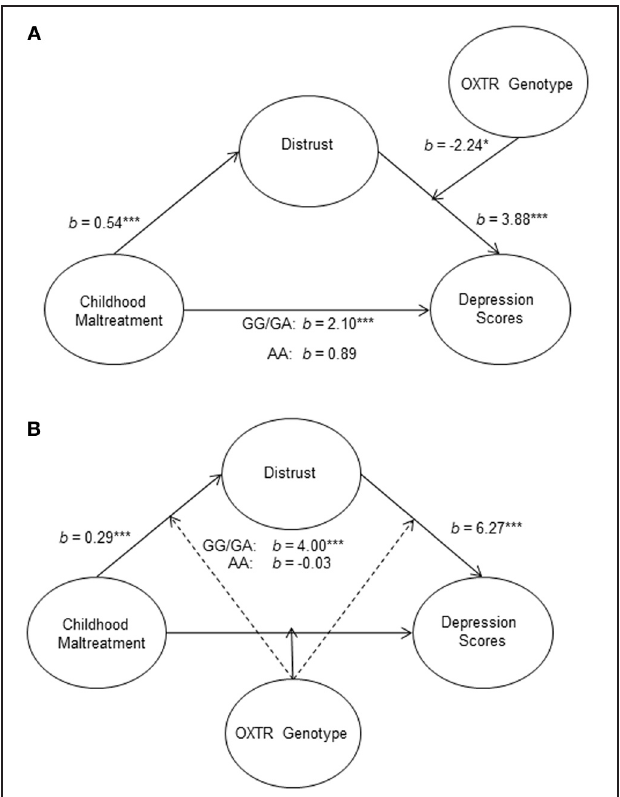
FIGURE 2 | Schematic representations of the moderated mediation models. The relation between childhood maltreatment and depression scores through distrust was moderated by OXTR rs53576 genotype (GG/GA vs. AA). This mediation model was found only to be significant among G carriers (A) . An alternative model was tested, in which the relationship between childhood maltreatment and depression scores through distrust was moderated at all three pathways. This time, only the direct path was moderated and again the effect was only observed among individuals with the GG/GA genotype (B) . ∗ p < 0 . 05, and ∗∗∗ p < 0 .